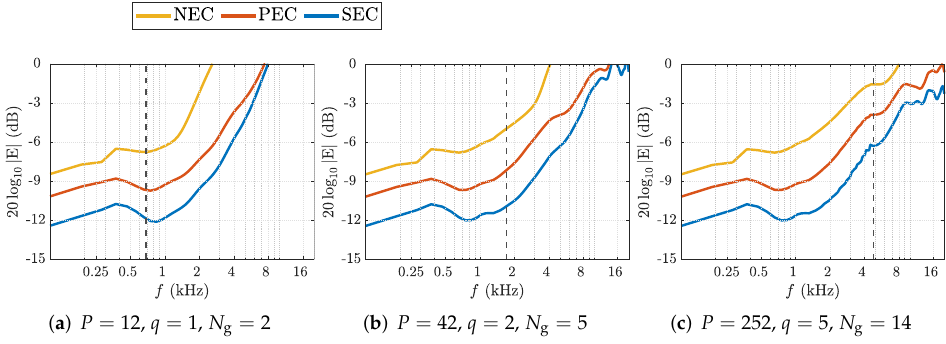
Figure 5. Synthesis error calculated with (21) in dB. Black-dashed lines indicate f max in